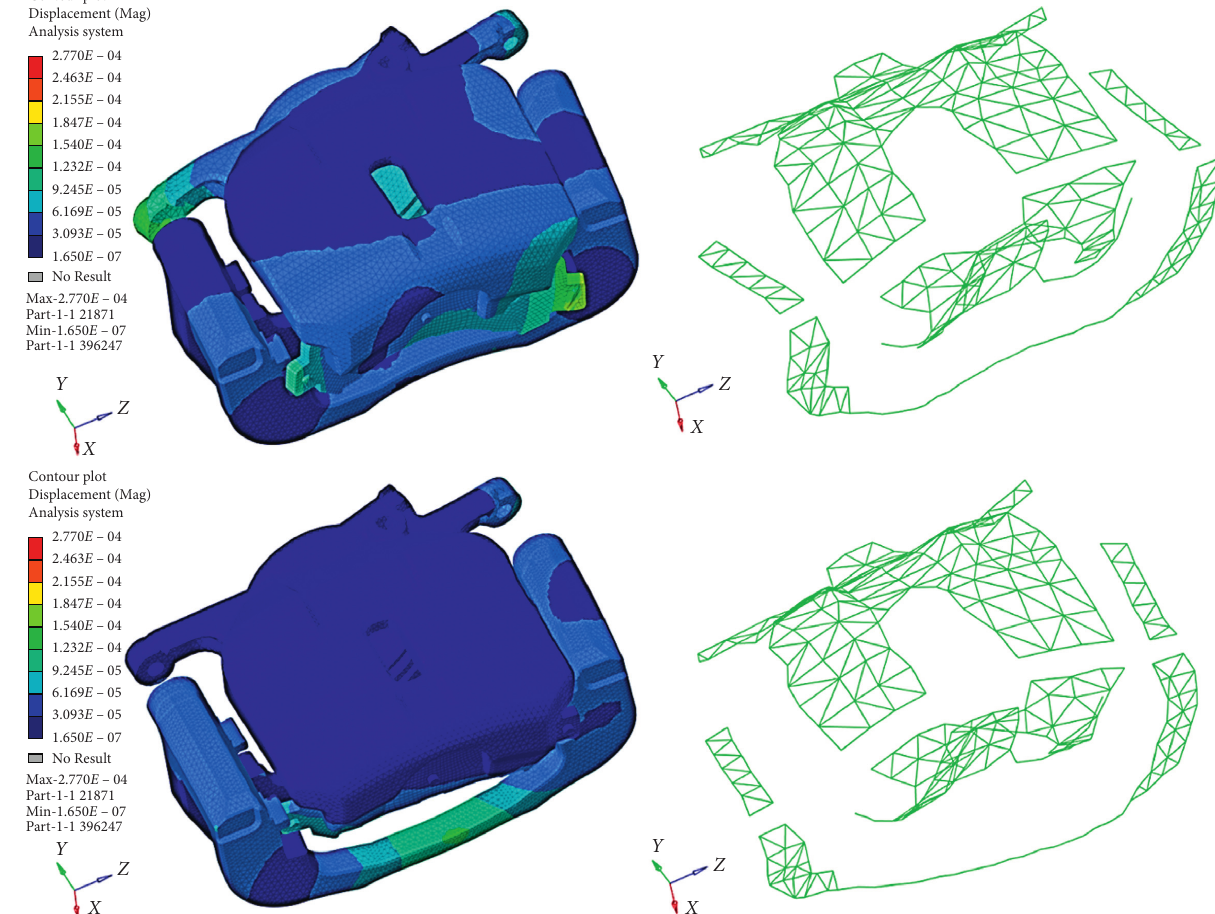
Figure 4: Mode shapes of numerical simulation near 3000Hz is similar to that of the ODS test.